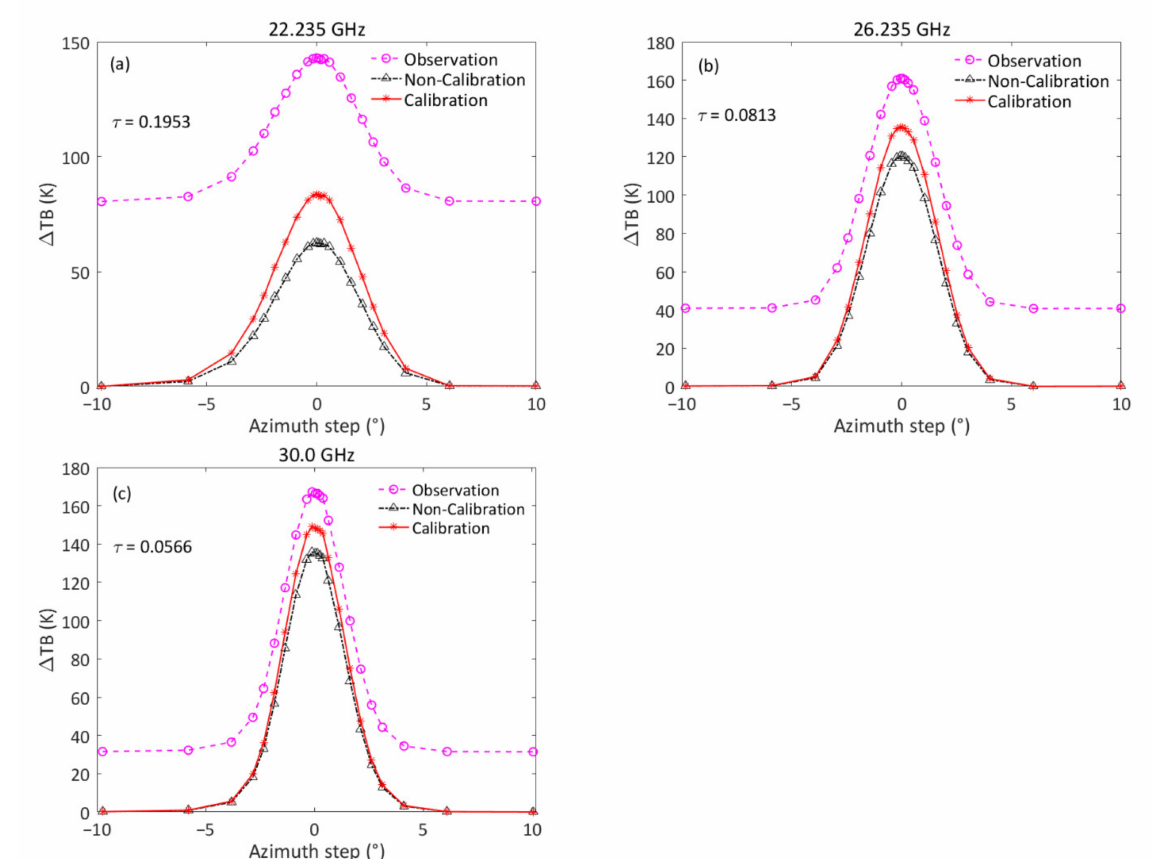
Figure 3. An example of the solar azimuth scanning observation on 18 June 2020, 12:00 a.m. (local time). The azimuth angle distortion was calibrated. The pink dashed line is the scanning points value. The red solid line is the TB increment after the atmospheric attenuation calibration and the black dash-dotted line is for the observational TB increment without the atmospheric attenuation calibration. The markers represent the observed data and the origin represents the center of the sun. The left axis is the solar TB increments ( ∆ TB) at different azimuths. ( a ) 22.235 GHz, ( b ) 26.235 GHz, and ( c ) 30.0